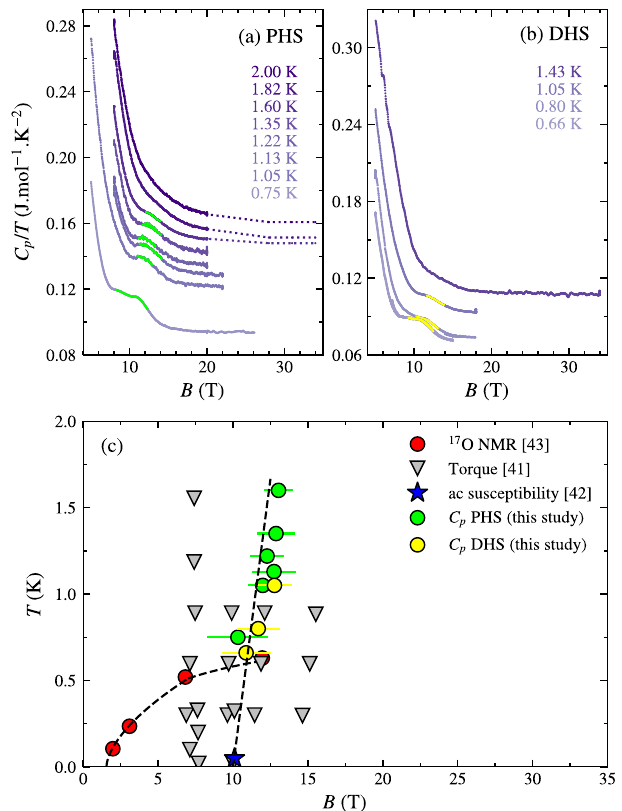
FIG. 5. (a,b) Field scans obtained at very low temperatures T ≤ 2 K on the PHS single crystal and the DHS single crystal, respectively. Tiny anomalies associated to a minute entropy gain are clearly evidenced at the lowest temperatures but quickly disappear for temperatures T ≥ 1 K. The parts highlighted in green (PHS) and yellow (DHS) delineate the anomalies (down- ward concavity). (c) Anomaly positions observed in the latter specific heat measurements reported in a B − T phase diagram, along with anomaly positions detected with other techniques ( 17 O NMR spin-lattice relaxation from Ref. [43], torque adapted from Ref. [41], and ac susceptibility adapted from Ref. [42]). The dashed lines are guides for the